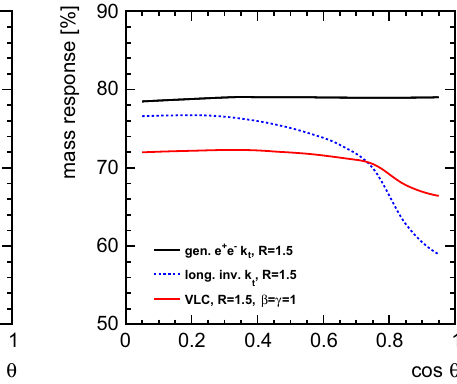
Fig. 8 The response to 1.5 TeV top jets as a function of polar angle for three jet algorithms, all with radius parameter R = 1.5. The left plot shows the median reconstructed jet energy, the right plot the mean